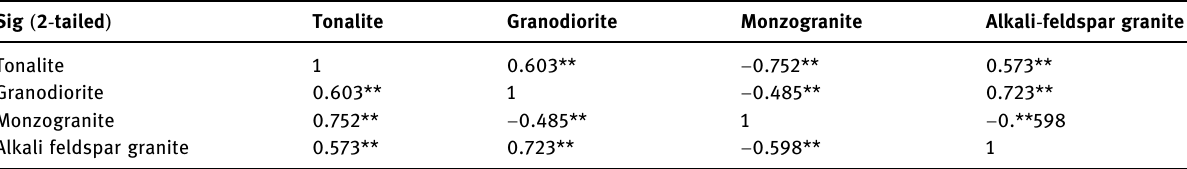
Sig. Notice ( P - value ) statistics ( Z ) between tonalite and granodiorite28.25 32.00 between tonalite and monzogranite31.46 57.67 between tonalite and alkali - feldspar granite19.17 34.17 between granodiorite and monzogranite39.94 65.60 between granodiorite and alkali - feldspar granite26.19 42.27 between monzogranite and alkali - feldspar granite52.81 58.88